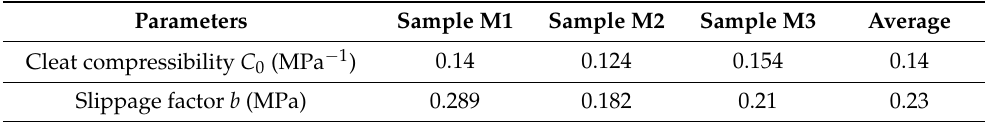
Figure 4. Fitting of the permeability model with experimental results under the hydrostatic stress of 8 MPa. Table 3. Parameters obtained from the fitting.